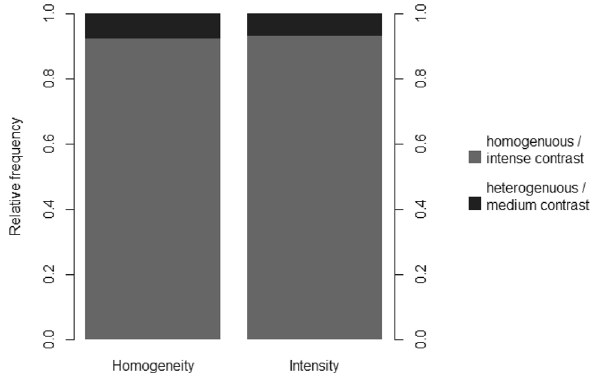
Figure 5. Intensity and homogeneity of contrast medium uptake. All meningiomas showed typical contrast enhancement features with at least medium but way dominant intensive contrast enhancement. Moreover the contrast enhancement was almost always homogeneous as expected. The intensity and homogeneity were the most helpful image feature for the readers.